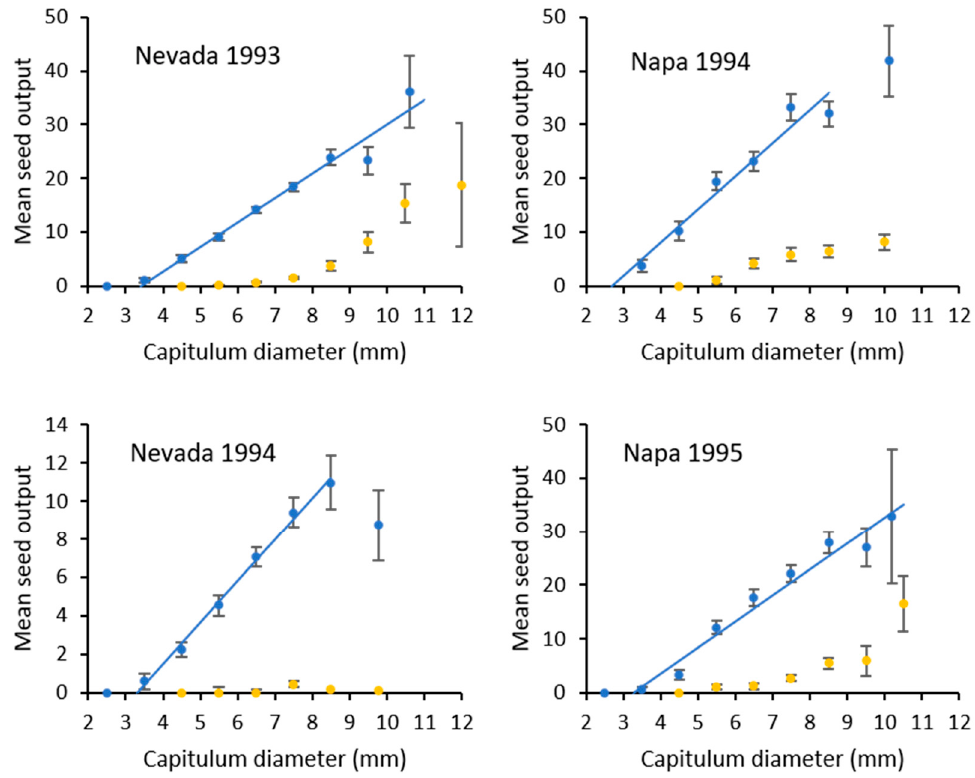
Figure 2. The relationship between capitulum diameter and the number of viable seed produced (mean ± SE) in attacked capitula (orange) and capitula without larval damage (blue). The regression equations are reported in Table